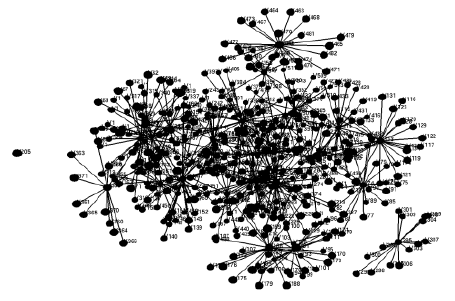
Fig. 8. Initial positioning of the graph of bibliometric network.